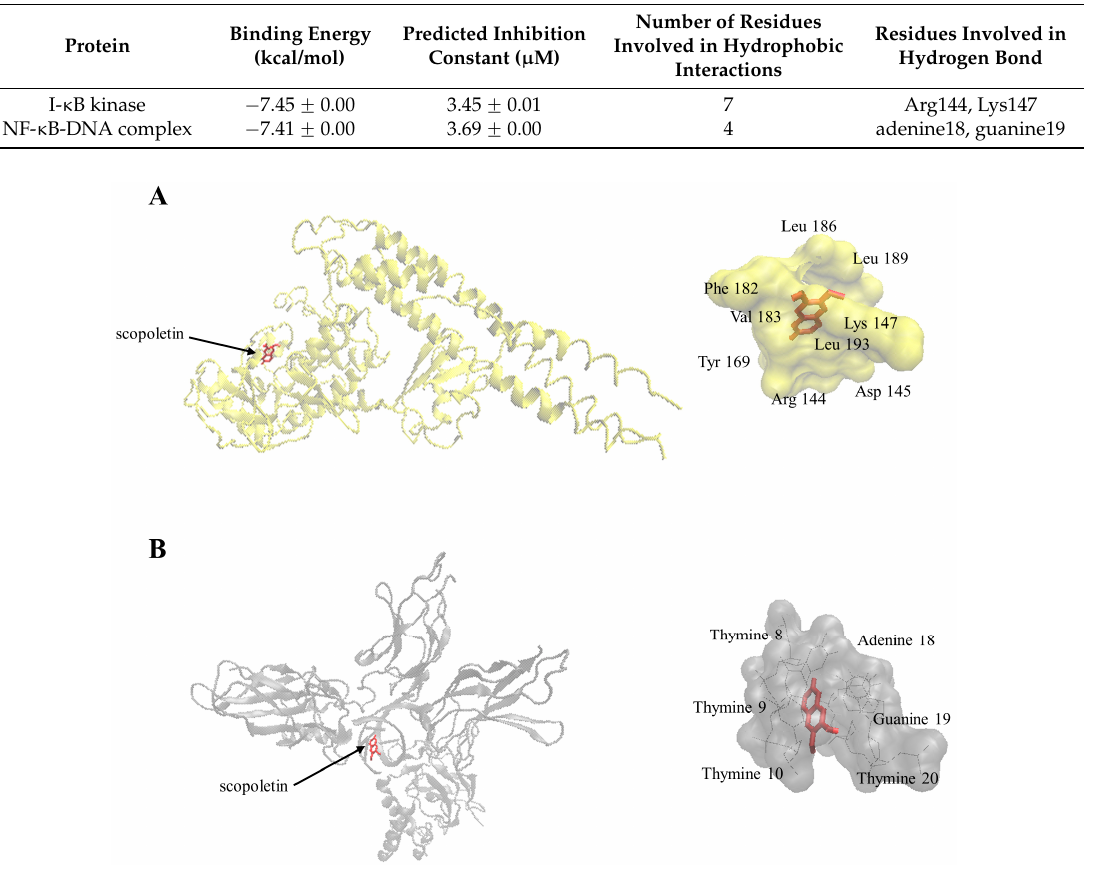
Figure 8. Molecular docking studies of scopoletin to NF- κ B pathway proteins. ( A ) Docking pose into the ATP binding site of I Κ K (PDB code: 3RZF in yellow cartoon representation); ( B ) Docking pose into the DNA binding site of NF- κ B-DNA complex (PDB code: 1VKX in gray cartoon representation). Table 4. Molecular docking of scopoletin to NF- κ B pathway proteins (details see Figure 8). Binding Predicted Number of Residues Residues Involved Protein Energy Inhibition Constant Involved in Hydrophobic in Hydrogen Bond (kcal/mol) (µM) Interactions I- κ B kinase Arg144, Lys147 adenine18, guanine19